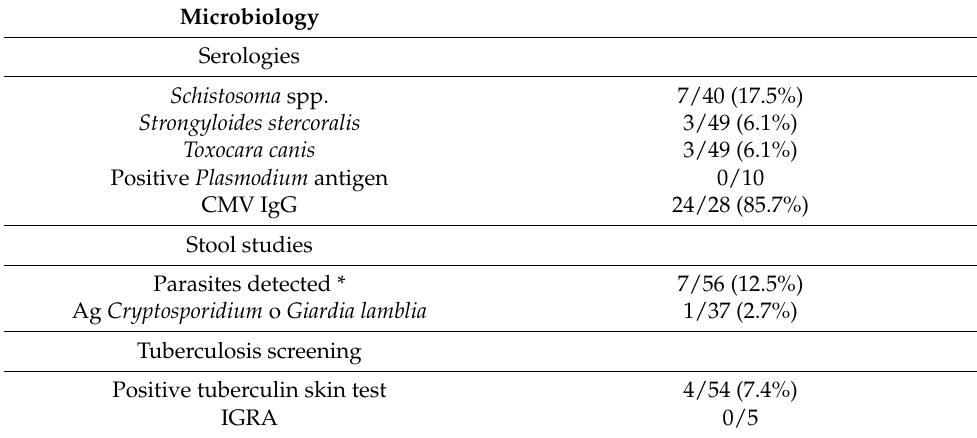
Table 4. Microbiologic tests performed after first visit upon